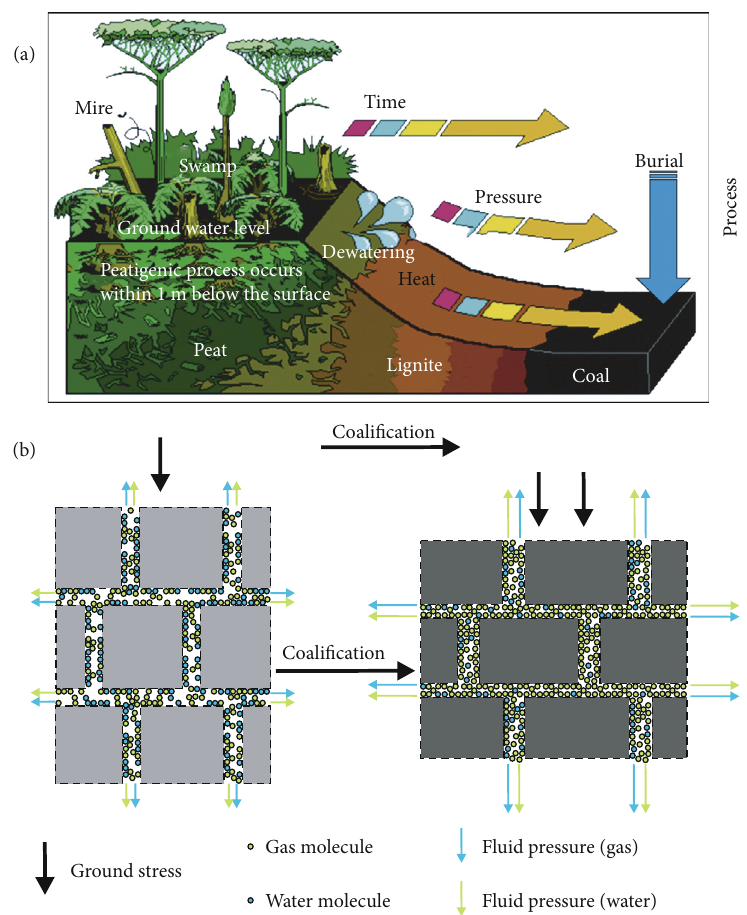
Figure 1: The diagram of the coali fi cation process and fl uid performance in coal reservoirs (modi fi ed from Greb et al.